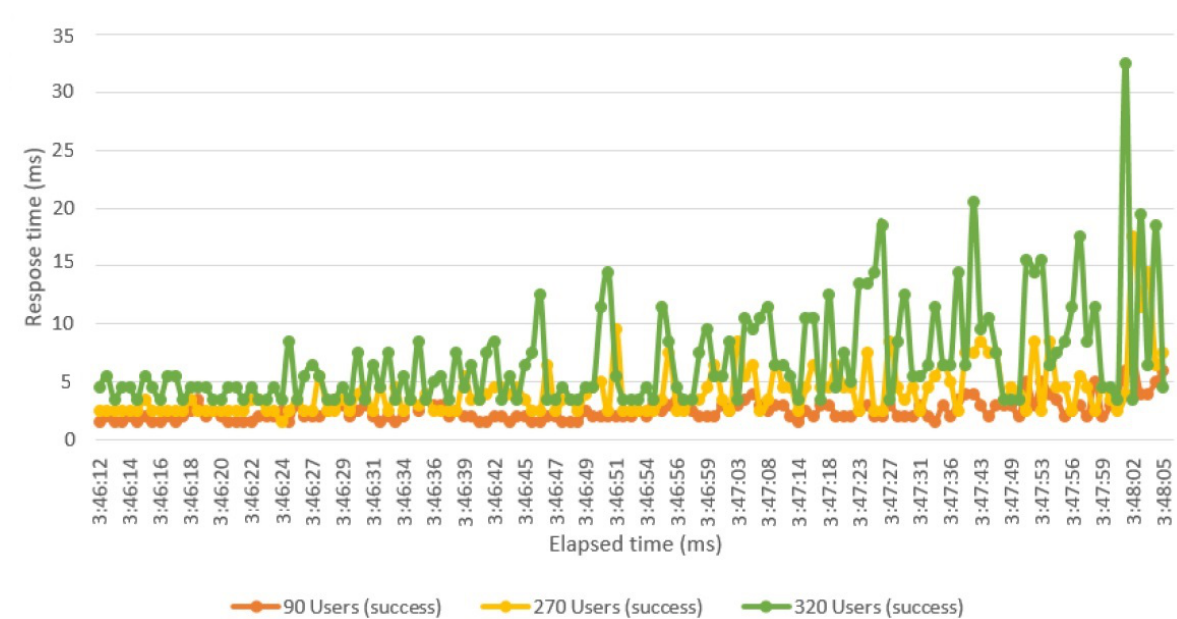
Figure 17. Different request response